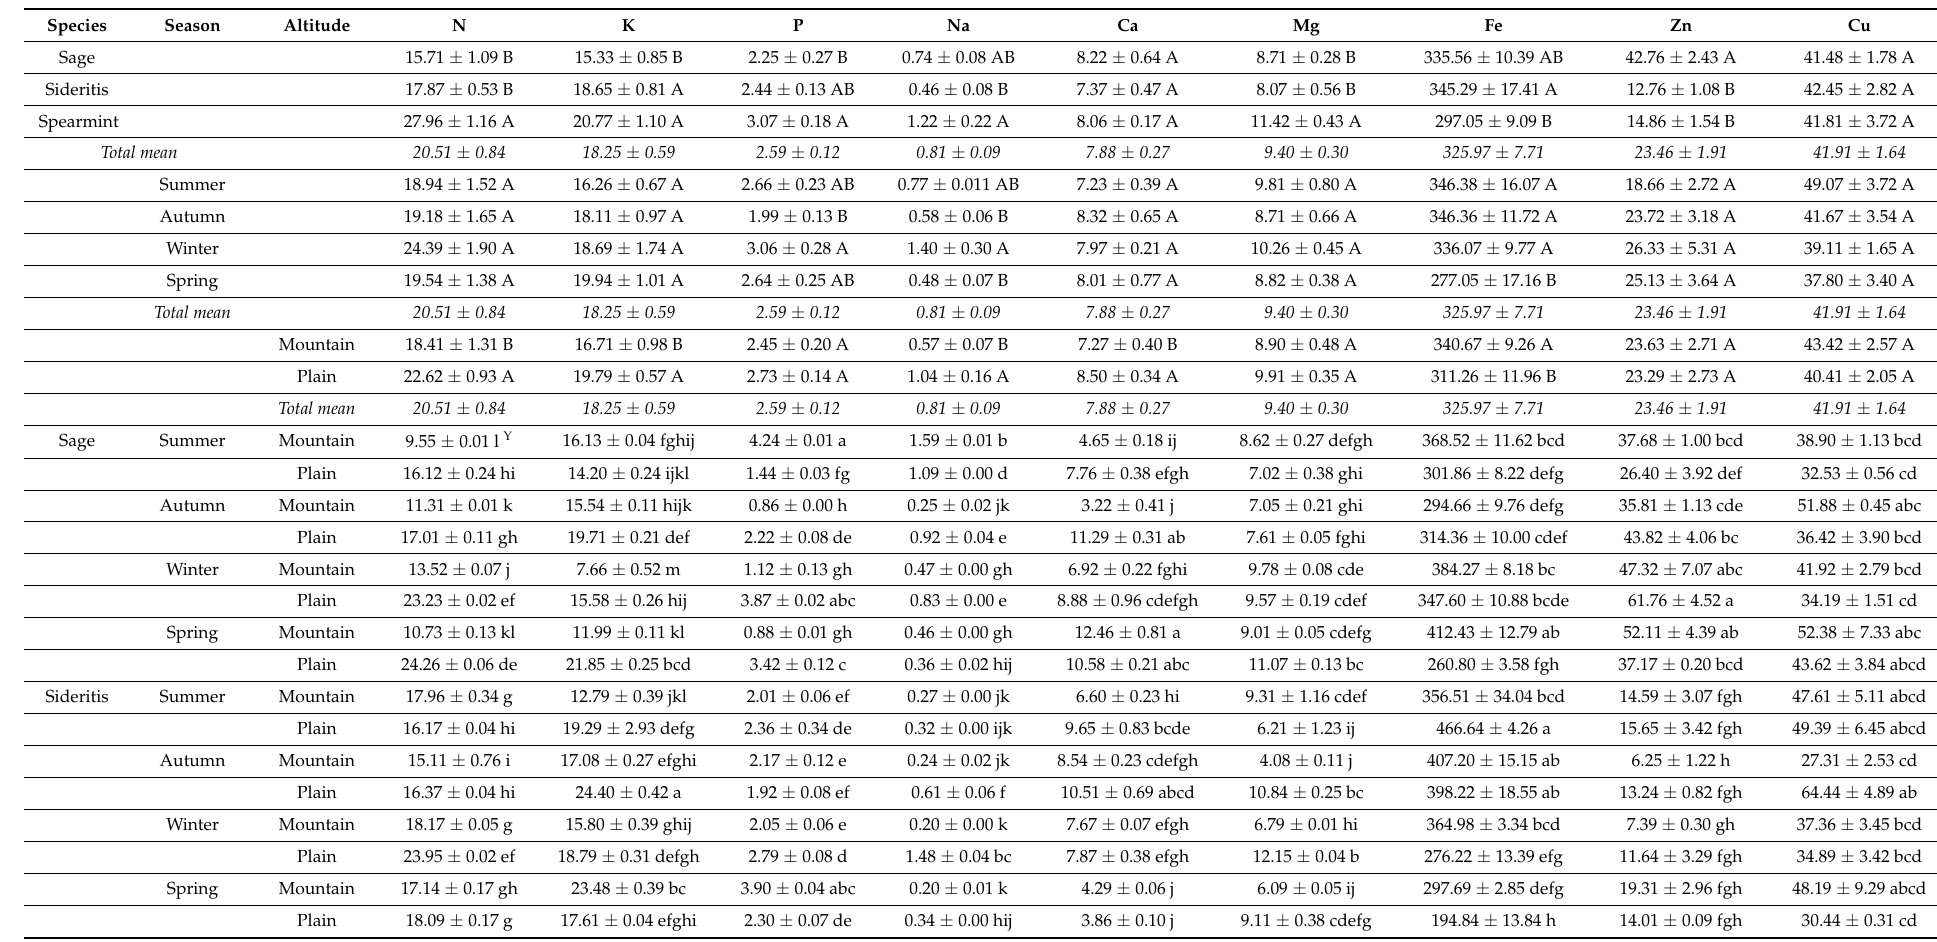
Table 4. Effects of altitude (mountain vs. plain) and season (summer, autumn, winter and spring) on the macronutrient (g kg − 1 ) and micronutrient content (mg kg − 1 ) content in selected medicinal plant